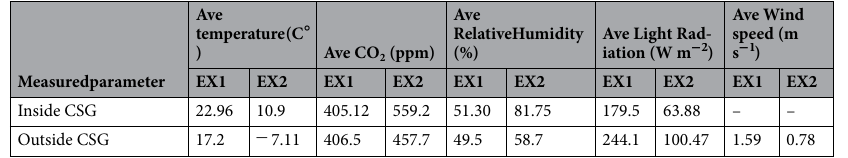
Table 1. Information about the collected datasets including measured parameters, measuring unit and average for each measured parameter during the experiment period. EX1 data is the dataset collected during the warm season for 35 days. EX2 data is the dataset collected during the cold season for 60 days.